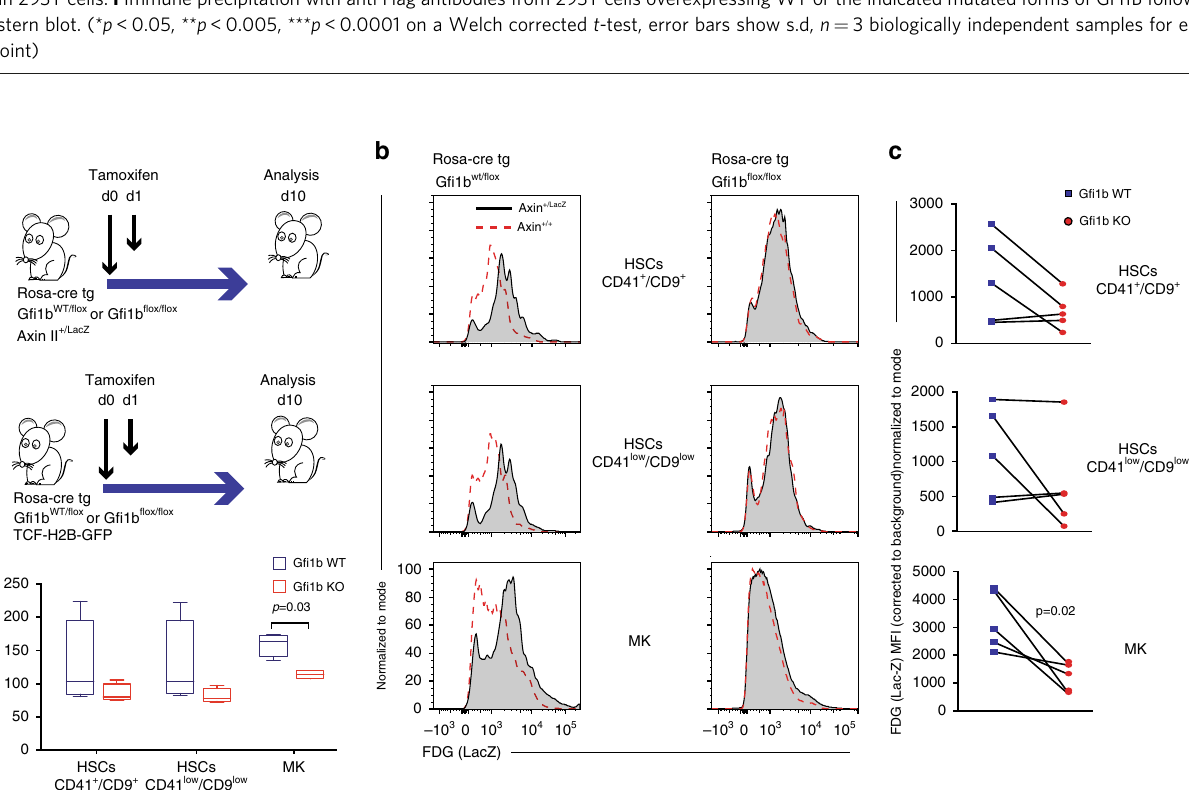
Fig. 4 GFI1B enhances transcription of a TCF dependent promoter/reporter system. a , b TOP/FOP fl ash reporter assay in 293T cells. Cells were transfected with the indicated plasmids together with TOP or FOP reporter constructs 36 h before luciferase measurement. GFI1B enhances the TOP/FOP ratio at both basal levels and following activation with a 10% Wnt3A-conditioned media or b co-transfection with active form of β -catenin and/or Wnt3A expressing vectors. c – e TOP/FOP fl ash reporter assay in 293T cells transfected with WT G fi 1b and the indicated mutated forms. Cells were treated with 25 mM LiCl (to activate canonical Wnt signaling in c and e ) for 5 h before luciferase measurement. f TOP/FOP fl ash reporter assay in 293T cells treated with CHIR99021, a speci fi c GSK3 β inhibitor for 5 h before luciferase measurement. g , h TOP/FOP fl ash reporter assay in 293T cells and GFI1B-TetON-U2OS cells transfected with the indicated vectors. i TOP/FOP fl ash reporter assay in U2OS cells stably expressing a doxycycline inducible GFI1B (Tet-ON system) transfected or not with a construct for TLE in the presence or absence of doxycycline. j , k TOP and modi fi ed TOP ( fl anked by GFI1B binding motifs) reporter assay in 293T cells. l Immune precipitation with anti Flag antibodies from 293T cells overexpressing WT or the indicated mutated forms of GFI1B followed by western blot. (* p < 0.05, ** p < 0.005, *** p < 0.0001 on a Welch corrected t -test, error bars show s.d, n = 3 biologically independent samples for each